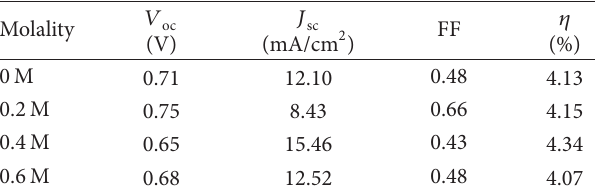
T4:PhotovoltaicparametersoftheDSSCbasedonthecompos-